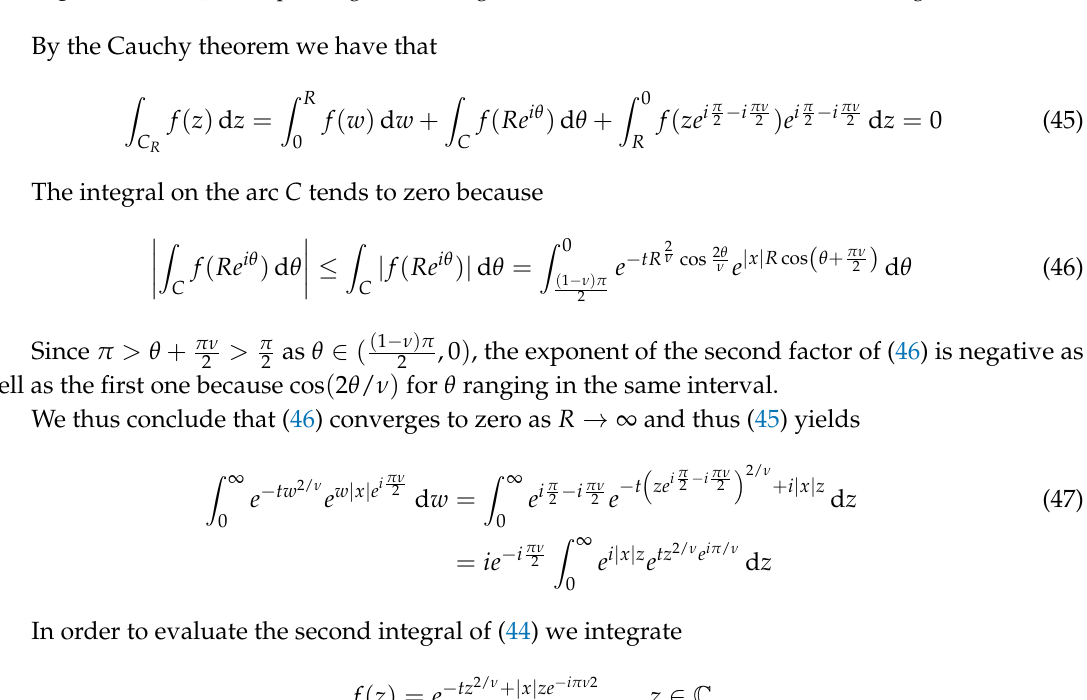
Figure 7. Path C R corresponding to the change of variables z (cid:48) = e i π 2 ( 1 − ν ) z in the first integral of